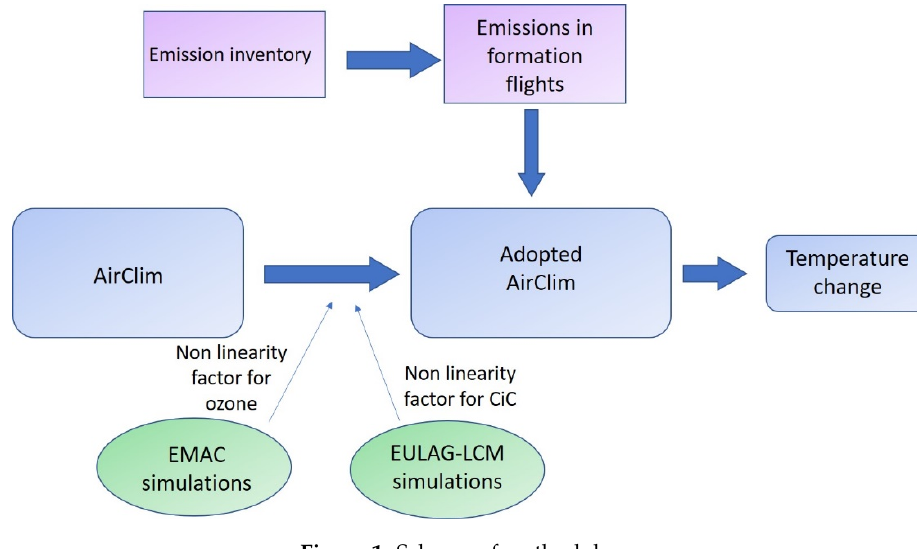
Figure 1. Schema of methodology.